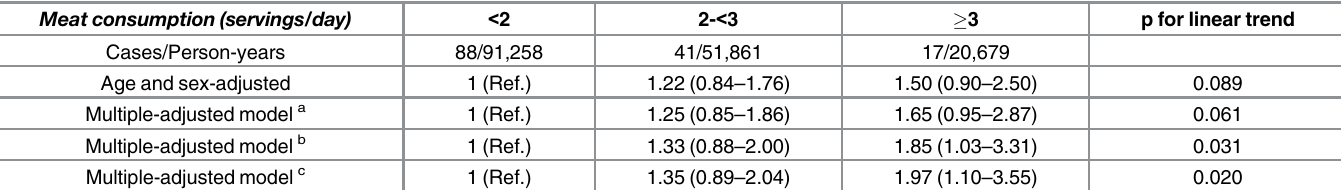
Table 2. HR and 95% CI for incident type 2 diabetes according to categories of daily meat consumption. The SUN Project 1999 – 2014. Meat consumption